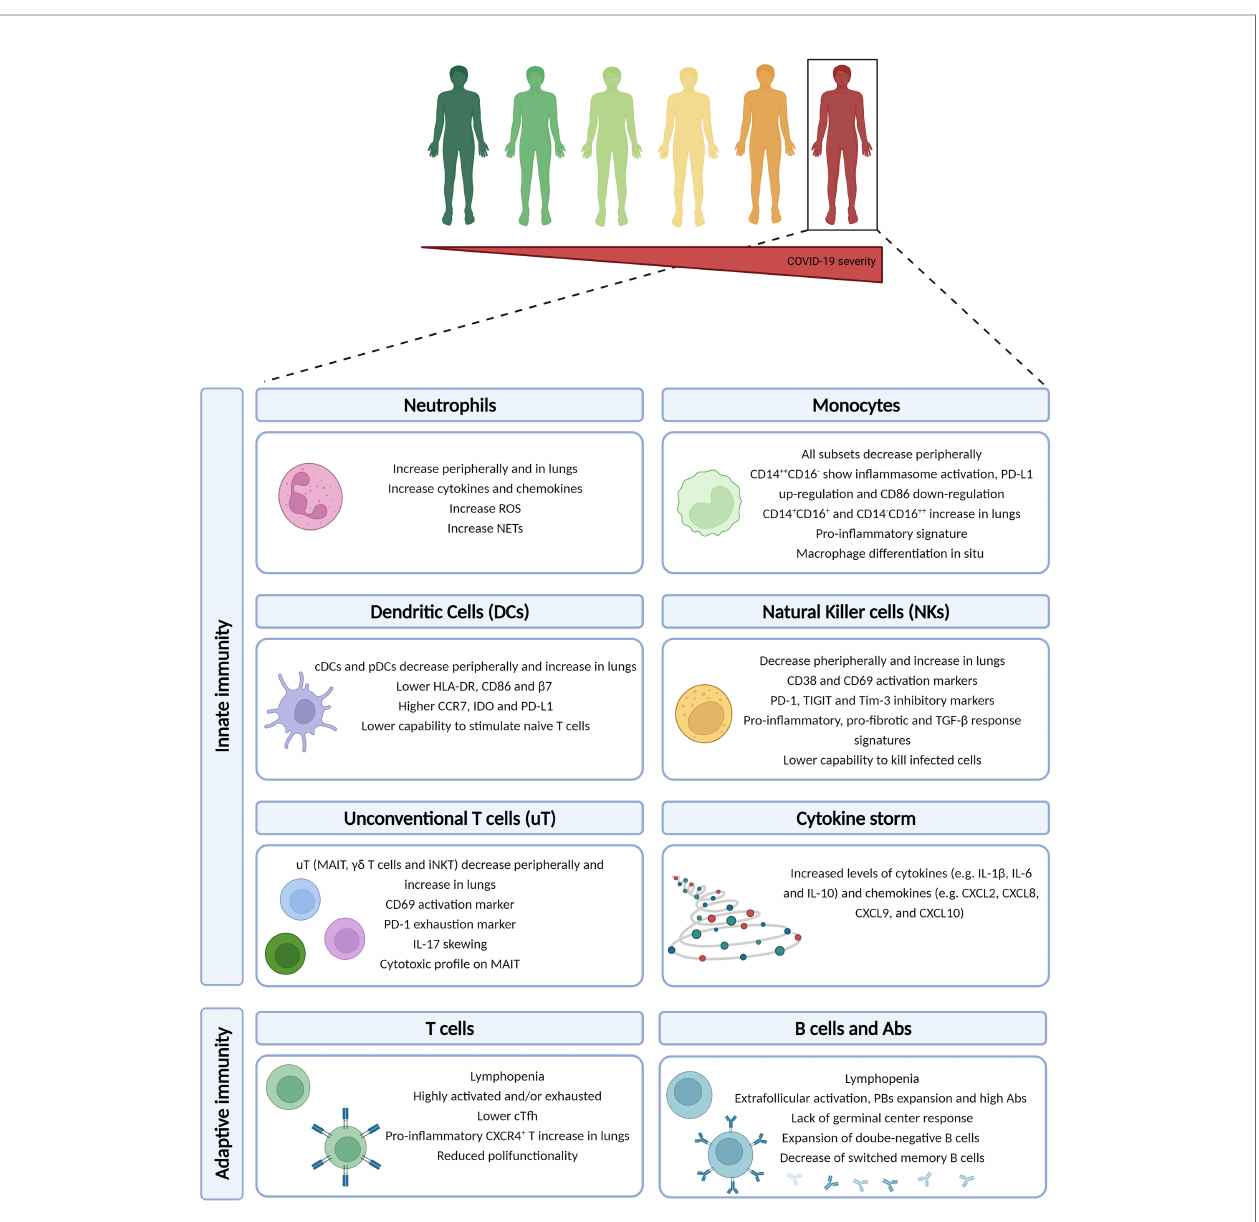
FIGURE 1 | Immune dysregulation in COVID-19 severe patients. The severe/critical form of COVID-19 disease is associated to a multi-layered immune dysregulation involving both innate and adaptive immune responses. Created with